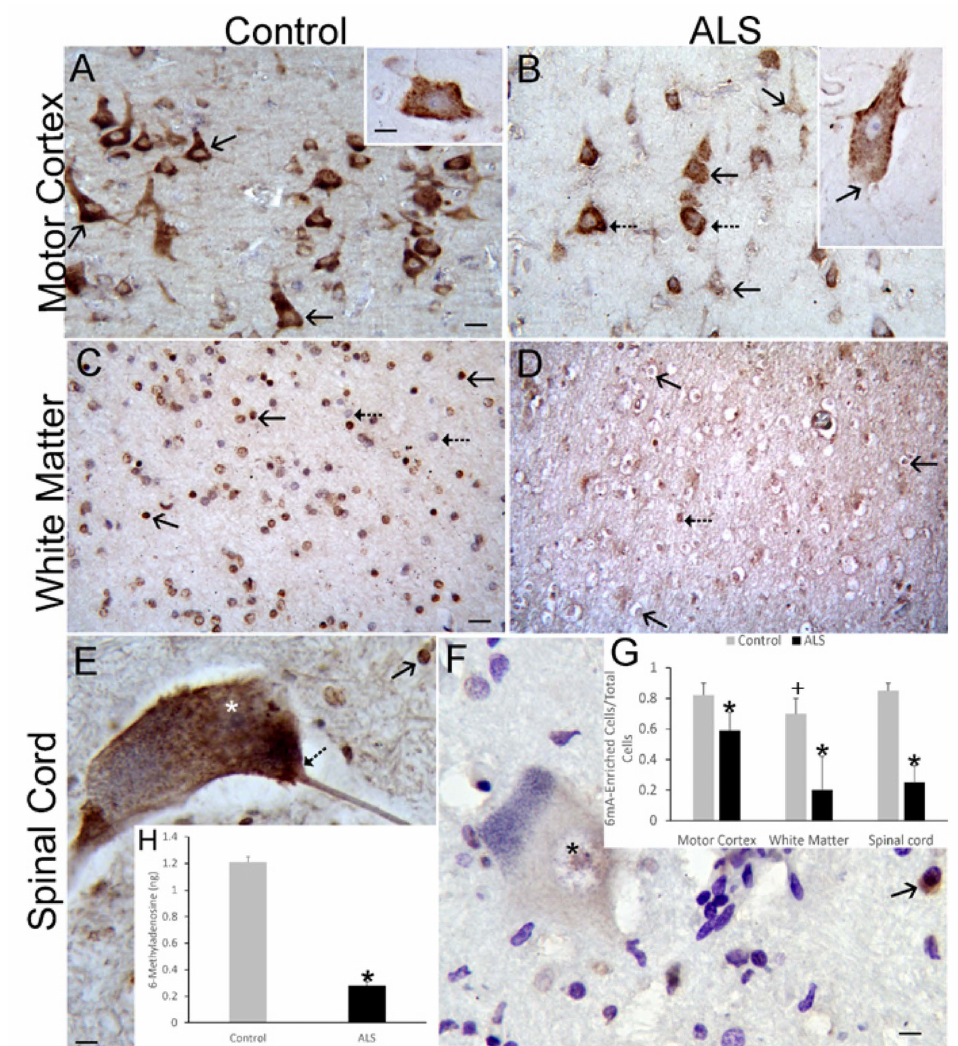
Figure 11. 6mA RNA methylation is depleted in postmortem human ALS upper MNs, white matter, and lower MNs. Sections were counterstained with cresyl violet. ( A ) In control motor cortex, layer V pyramidal neurons (arrows) are enriched in 6mA IR (brown). The cytoplasm is strongly positive but the nucleus is less enriched (inset). See G for quantification. ( B ) In ALS motor cortex, layer V pyramidal neurons (solid arrows) have diminished 6mA IR (brown) in the cytoplasm and the nucleus compared to control. Subsets of pyramidal neurons remain enriched (hatched arrows). Neocortical layer V Betz cells, with a chromatolytic morphology (inset), have depleted 6mA in the nucleus, cytoplasm, and axon hillock (arrow). ( C ) Subcortical white matter in human controls is enriched in cells with nuclear IR for 6mA (solid black arrows). These cells have a nuclear morphology of oligodendrocytes [67]. Some cells are less intensely positive (hatched black arrows). ( D ) In the subcortical white matter of human ALS cases, many cells with an oligodendrocyte morphology show 6mA depletion (solid black arrow); few cells appear less affected (hatched arrow). ( E ) In human control spinal cord, the α -MNs are enriched in 6mA throughout the cytoplasm, including the axon hillock (hatched arrow), and nucleus (*). Small glial cells are also positive (solid arrow). ( F ) In human ALS spinal cord, the MNs are attritional and have severe depletion of cytoplasmic and nuclear (asterisk) 6mA. Scale bars: ( A ) (same for ( B )), 15 µ m; ( A ) (inset), 7 µ m; ( C ) (same for ( D )), 20 µ m; ( E ) (same for ( F )), 10 µ m. ( G ) Counts (mean ± SD) of motor cortical pyramidal neurons, white matter glial cells, and spinal MNs with enrichment of 6mA in control ( n = 6) and ALS ( n = 8) cases. + p < 0.05; * p < 0.01. ( H ) ELISA determination of the nanogram (ng) amount (mean ± SD) of 6mA in cervical spinal cord of human control ( n = 6) and ALS ( n = 8) cases. * p <